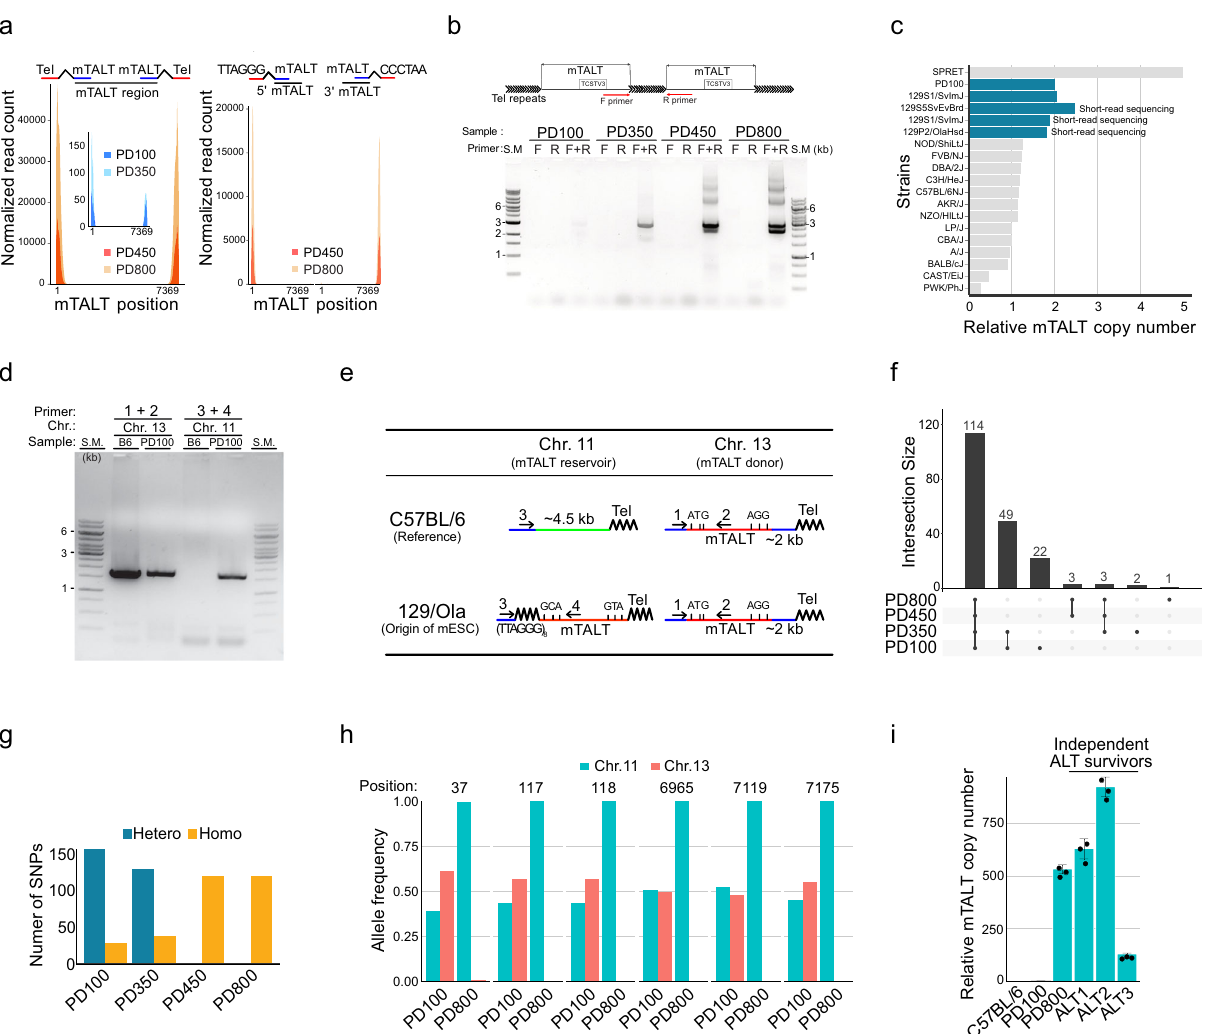
Fig. 2 A speci fi c copy of mTALT is duplicated in a constant orientation. a (Left) Alignment of the mate reads of telomere-containing reads. (Right) Alignment of the mate reads of telomere-containing reads in a strand-speci fi c way. b (Top) Schematics of the tandemly duplicated mTALTs and the speci fi c primers used. (Bottom) PCR assays showing the directionality of mTALT duplication. c Calculated copy numbers of mTALTs from WGS data of various mouse strains. d PCR assays elucidating the presence of mTALT on chromosome 11. e Schematics of the mTALT region in chromosomes 11 and 13 of the reference (C57BL/6J) and 129/Ola genome. f SNP analysis of the mTALT region at each time point. The connected lines denote groups sharing SNPs. g Number of SNPs sorted by allelic zygosity. h Frequencies of representative SNPs in mTALT region. i Calculated copy numbers of mTALTs from independent ALT survivors. The bars represent the means and SDs from three biologically independent replicates. Source data are provided as a Source Data fi